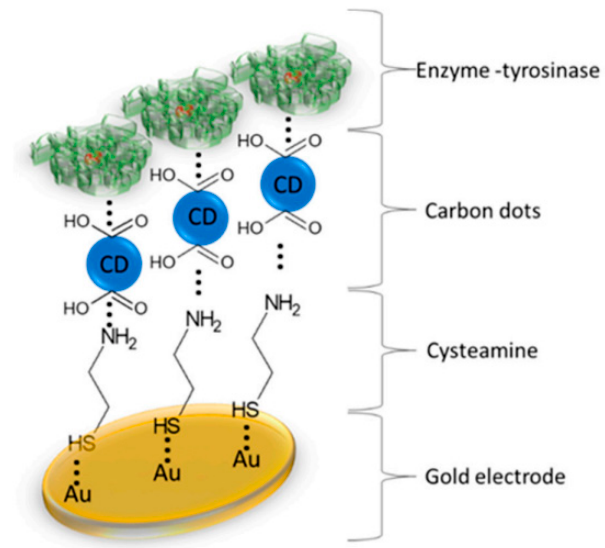
Figure 10. Schematic of the Gold-Electrode/Cysteamine/Carbon Dots/Tyrosinase biosensor [184].